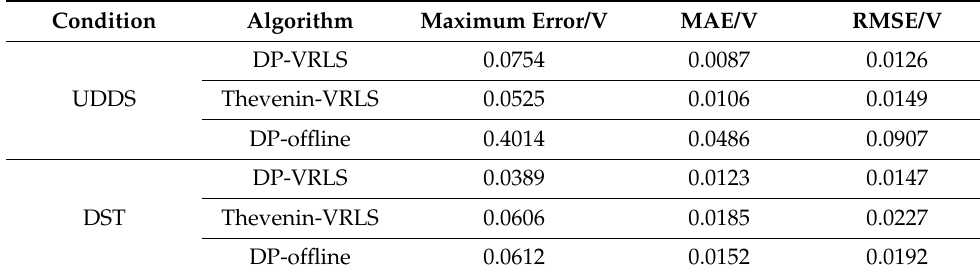
Table 4. Error of terminal voltage